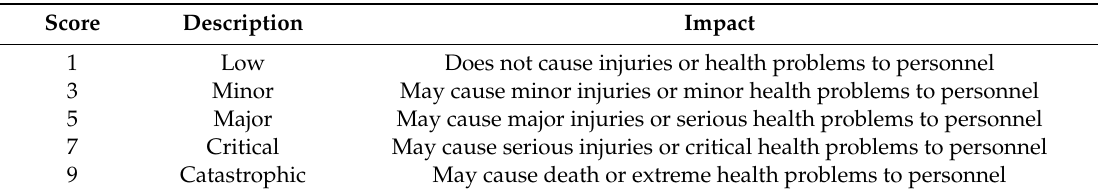
Table 6. Impact on People Scores and Description.